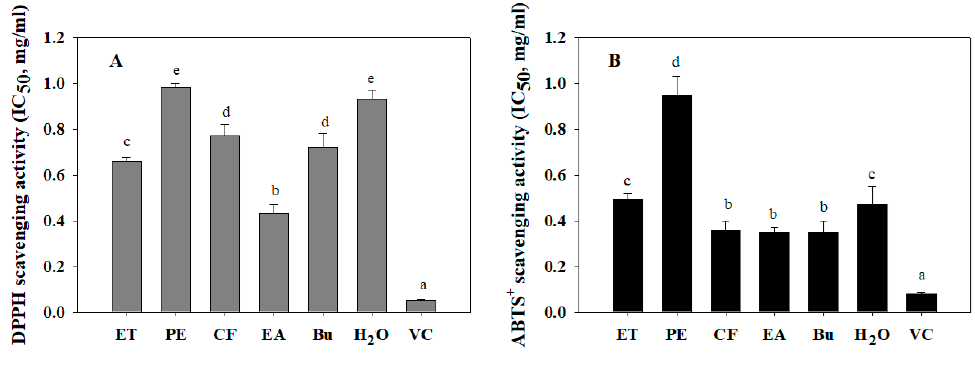
Figure 1. 1,1-diphenyl-2-picryl-hydrazyl (DPPH) ( A ) and 2,2-azinobis-3-ethyl benzothiazoline-6-sulfonic acid (ABTS) + ( B ) scavenging activities of wild bitter melon extract and fractions. IC 50 is the half maximal inhibitory concentration of extract or fractions on DPPH or ABTS + radicals. Each determination was made in three independent experiments, and the data are shown as means ± standard deviation (SD). Different letters a–e indicate significant differences among groups ( p < 0.05). Ethanol extract (ET), petroleum ether (PE), chloroform (CF), ethyl acetate (EA), n-butanol (Bu), H 2 O fraction, and Vitamin C (VC, 20 μ g/mL).